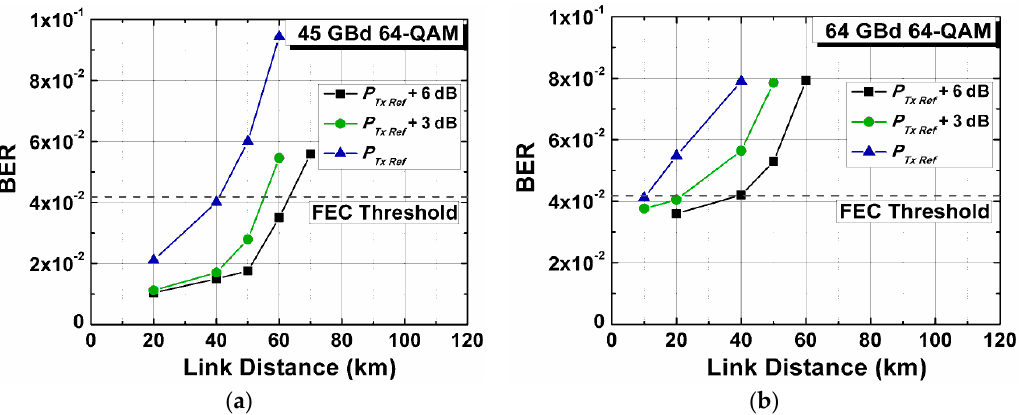
Figure 7. BER as a function of transmission distance in unamplified point-to-point link for ( a ) 45 GBd 64-QAM signals; ( b ) 64 GBd 64-QAM signals.